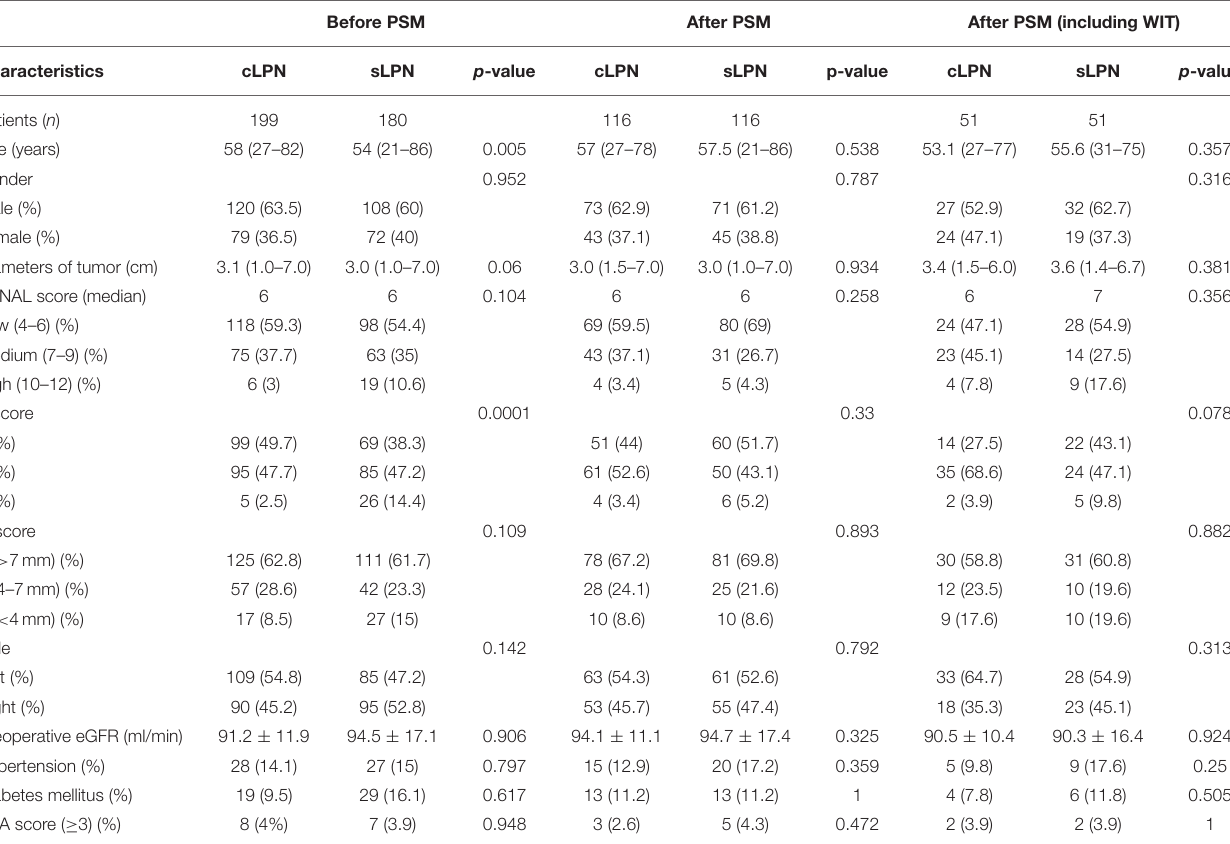
TABLE 1 | Preoperative features of the patients before and after PSM. Before PSM After PSM After PSM (including